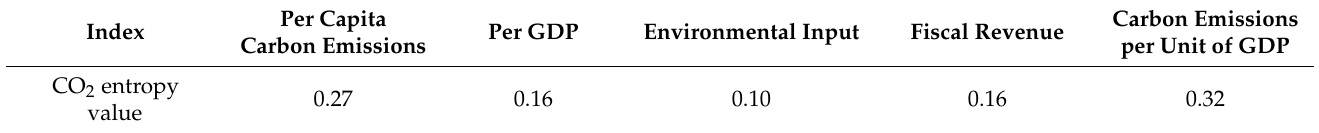
Table 3. Weight of the carbon total allocation